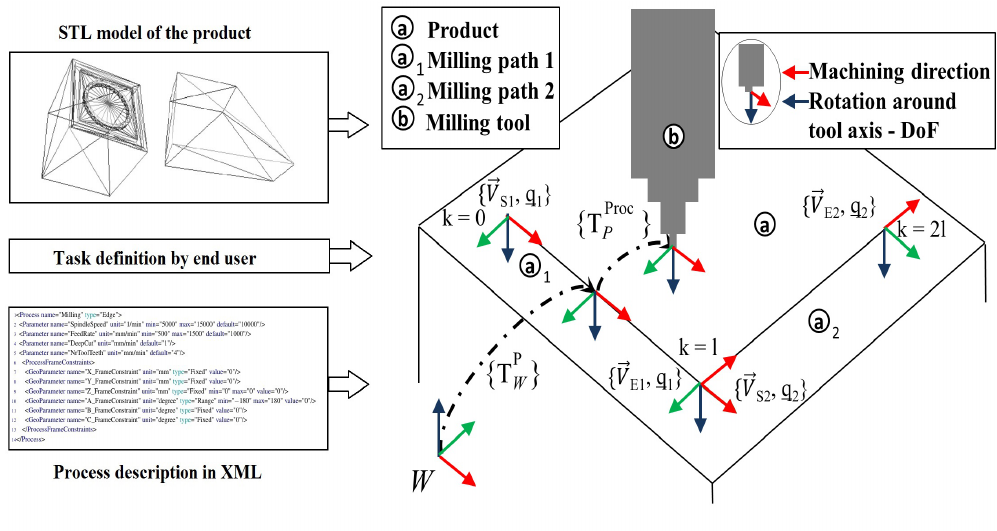
Figure 5. Illustration of the milling paths on the product and process model and its notations for two